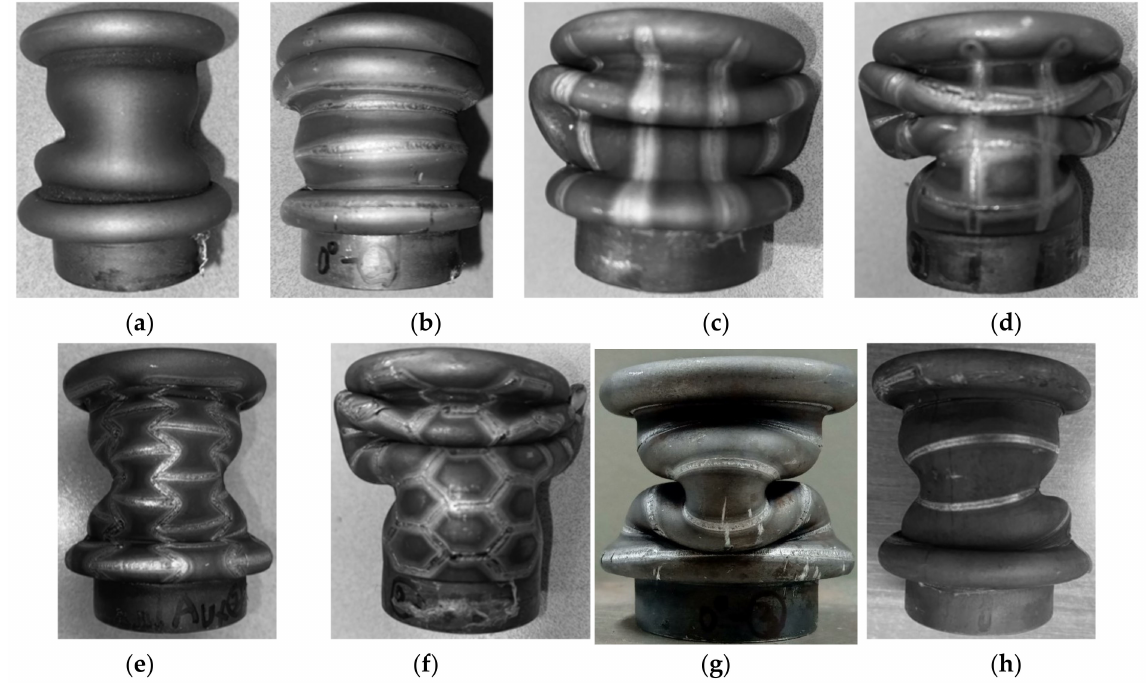
Figure 7. Deformed shapes with respect to laser patterning: ( a ) initial; ( b ) 0 ◦ ; ( c ) 90 ◦ ; ( d ) grid;